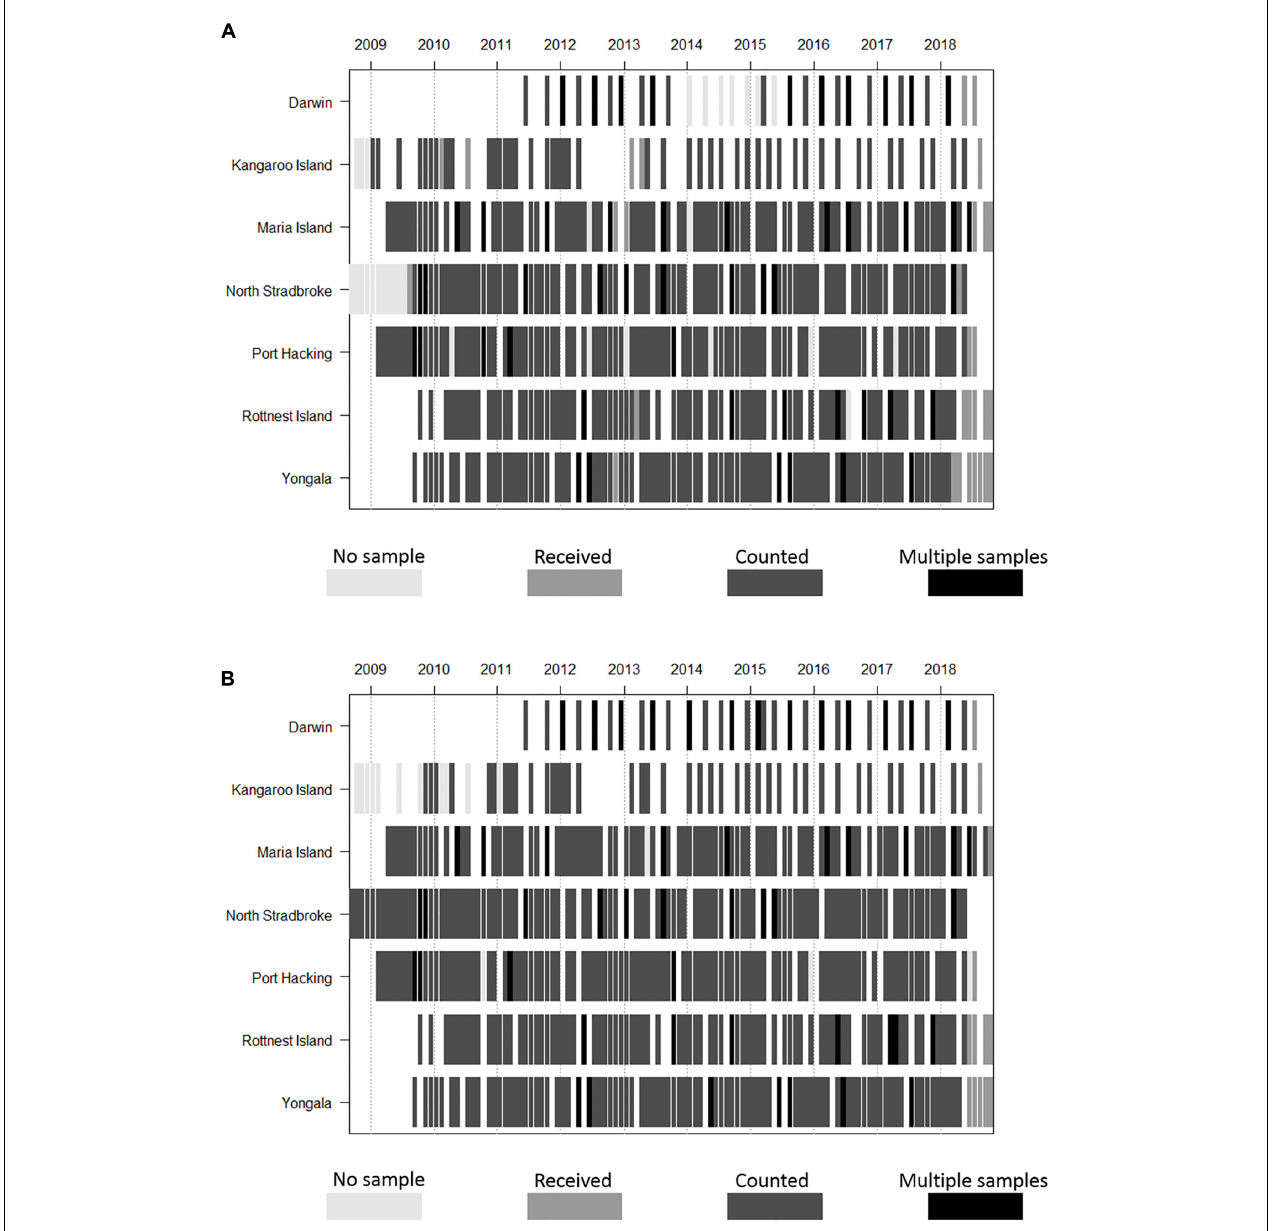
FIGURE 2 | Frequency and duration of (A) phyto- and (B) zooplankton monitoring time-series at NRS stations, under IMOS. Note that Ningaloo and Esperance (not shown) are no longer sampled due to resource constraints and that Darwin and Kangaroo are samples are collected